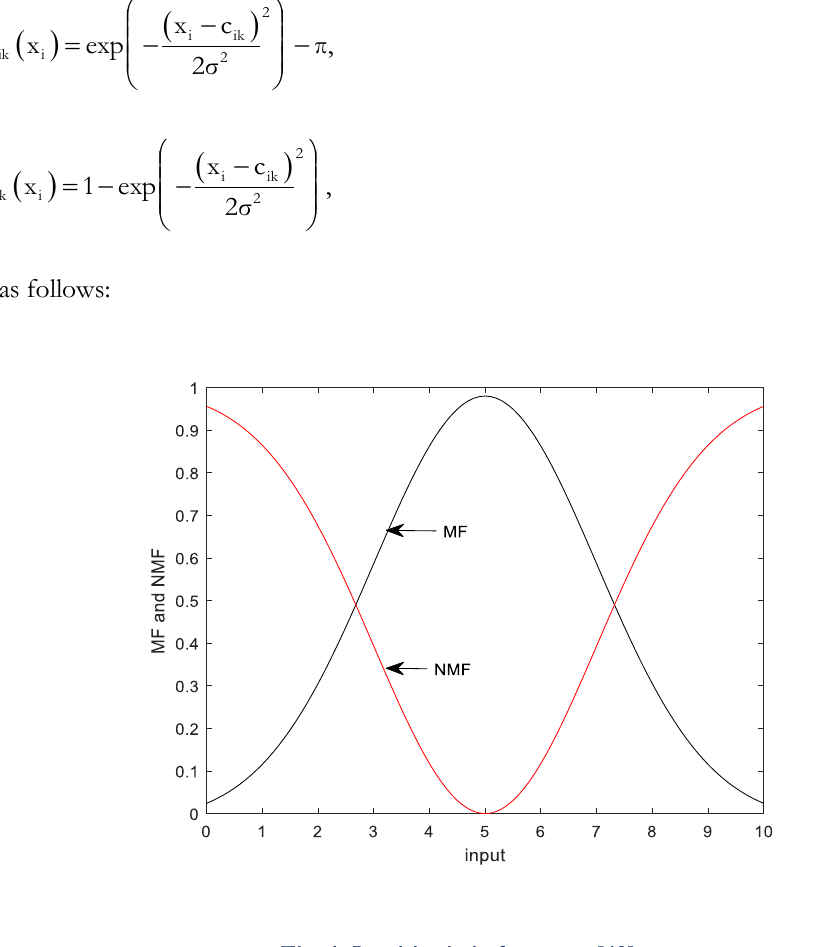
Fig. 1. Intuitionistic fuzzy set